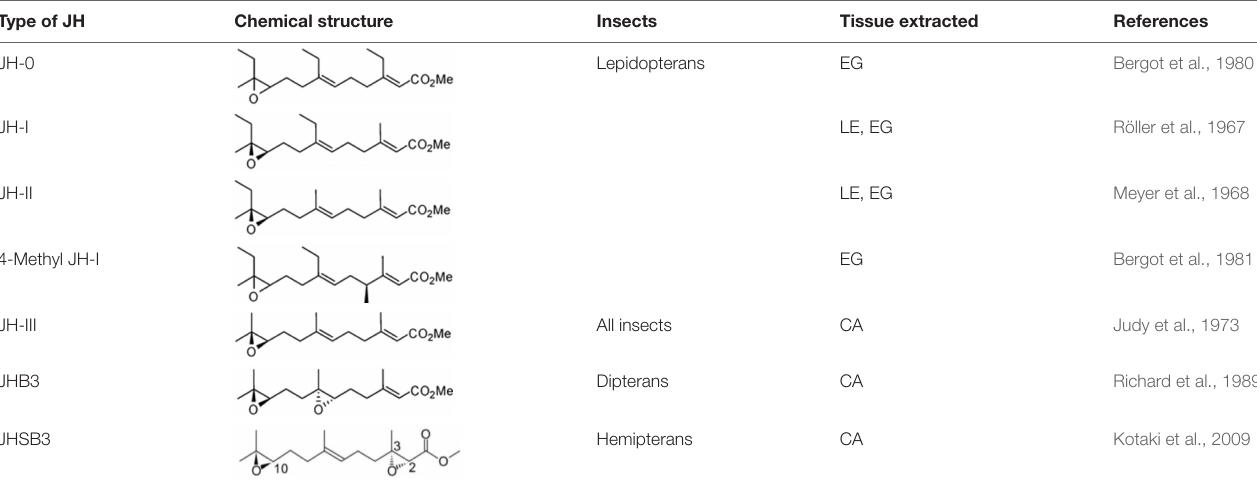
TABLE 1 | Different types of juvenile hormones isolated from